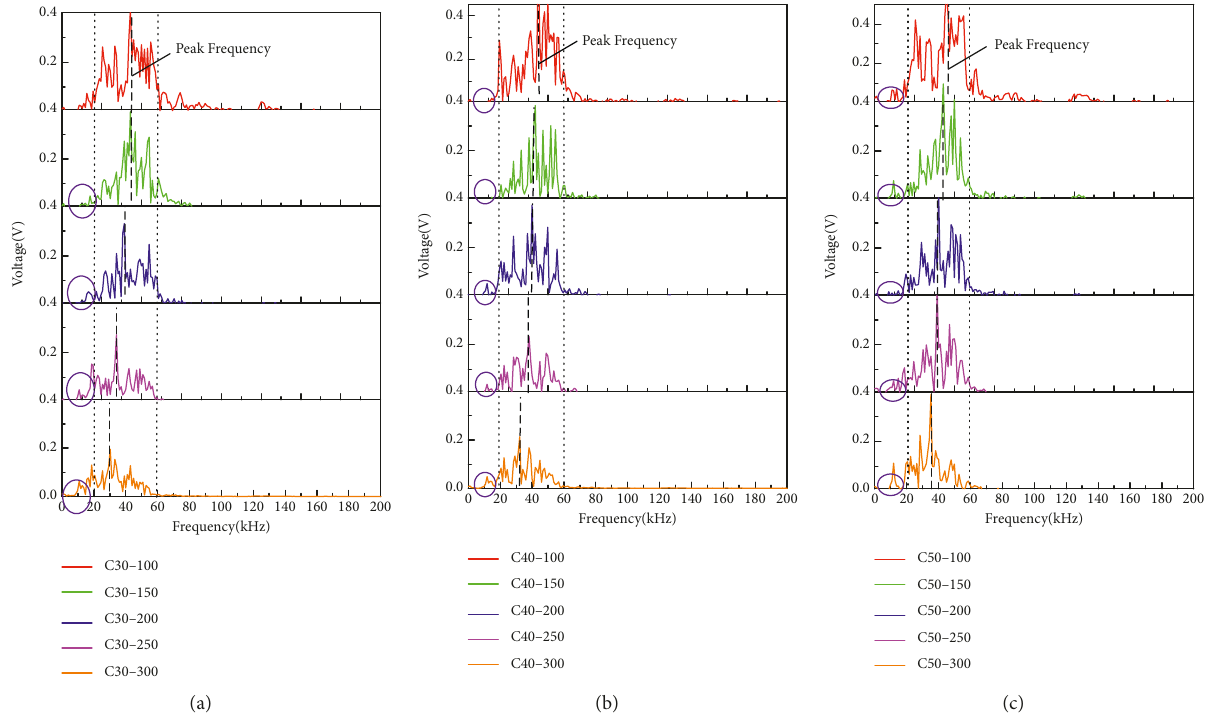
Figure 11: Frequency domain spectra of acoustic emission signals in concrete with strength grade. (a) C30, (b) C40, and (c)